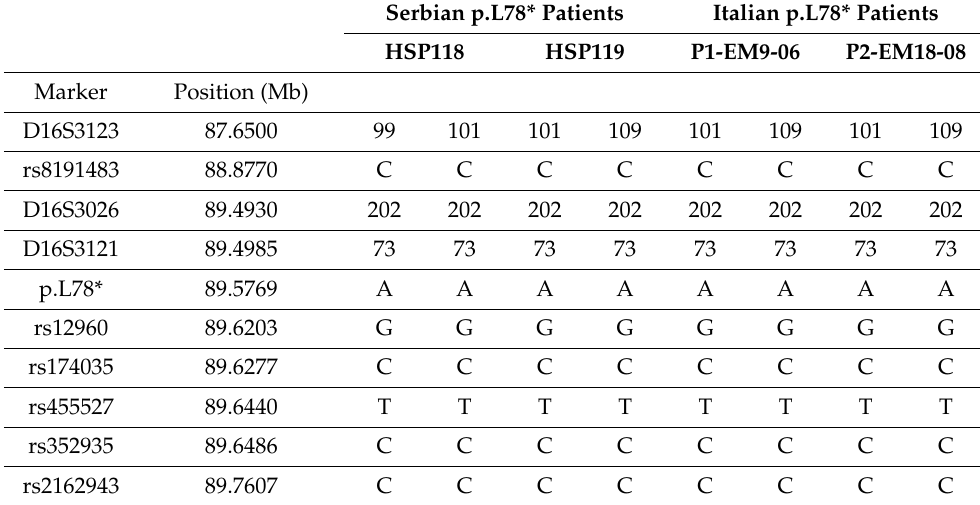
Table 4. Haplotype sharing analysis for the p.L78* mutation in SPG7